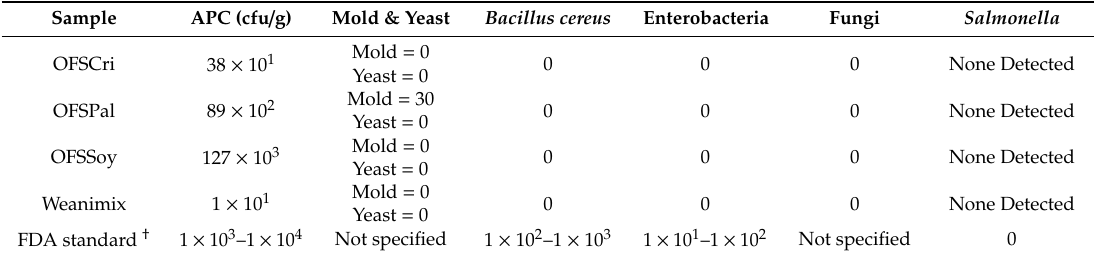
Table 4. Microbial quality of orange-fleshed sweet potato based complementary foods and Weanimix.